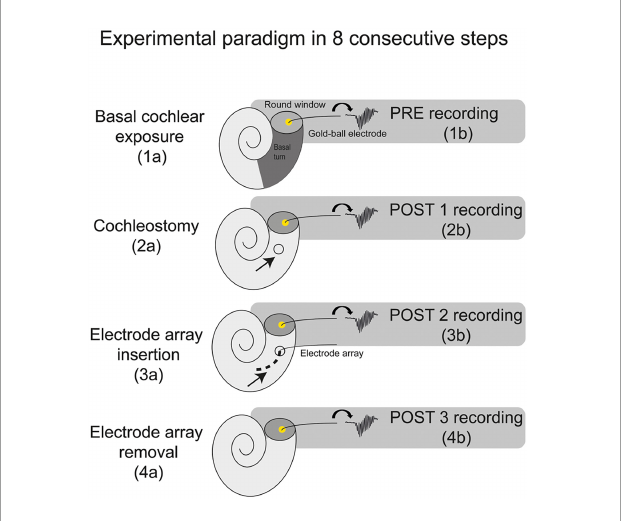
FIGURE1 A schematic overview of the experimental paradigm. The electrocochleography was performed using the gold-ball electrode in the round window niche. The experiments consisted of 8 consecutive steps, with electrocochleography at 4 separate stages of the procedure, i.e., at PRE (before cochleostomy), POST1 (after cochleostomy), POST2 (after electrode-array insertion), and POST3 (after electrode-array